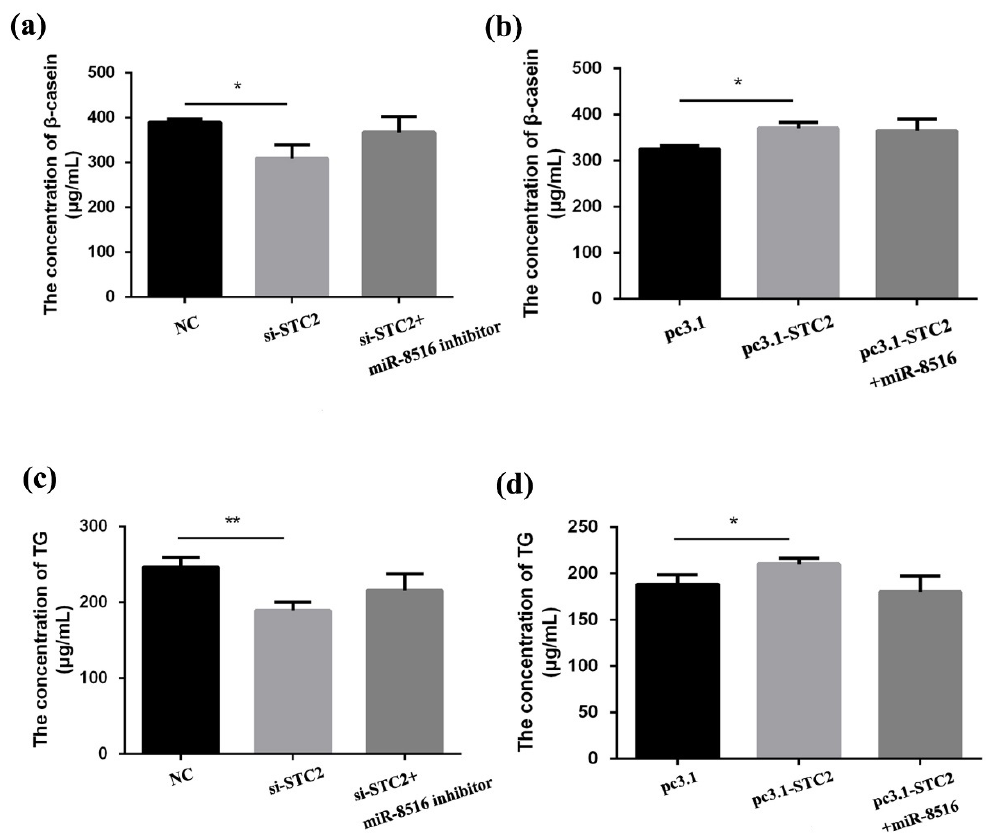
Figure 6. STC2 enhanced the synthesis of β -casein and triglycerides in GMEC. ( a , b , c , d ) Secretion of β -casein and triglycerides (TG) after transfection with pc3.1-STC2 or si-STC2 was measured by enzyme-linked immunosorbent assay kit. ** p < 0.01, * p <